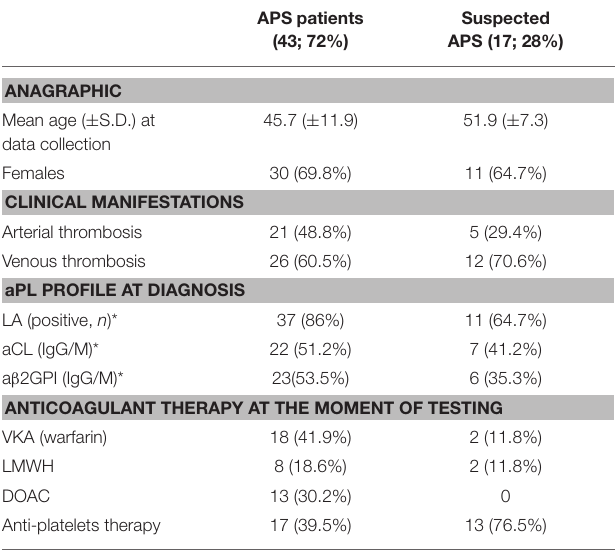
TABLE 1 | Characteristics of the patients included in the